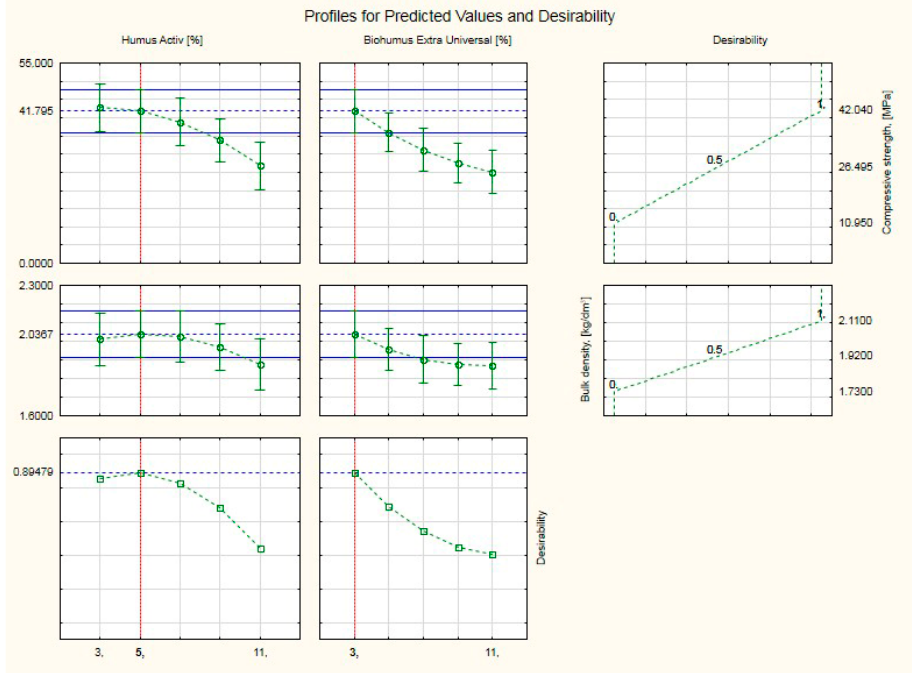
Figure 20. Profiles of predicted values and desirability. Profile of overall usability (compressive strength and bulk density) of silicate products with Humus Activ and Biohumus Extra Universal, for optimum values across the range.